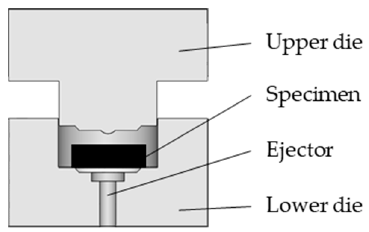
Figure 2. Schematic of the die with the specimen.